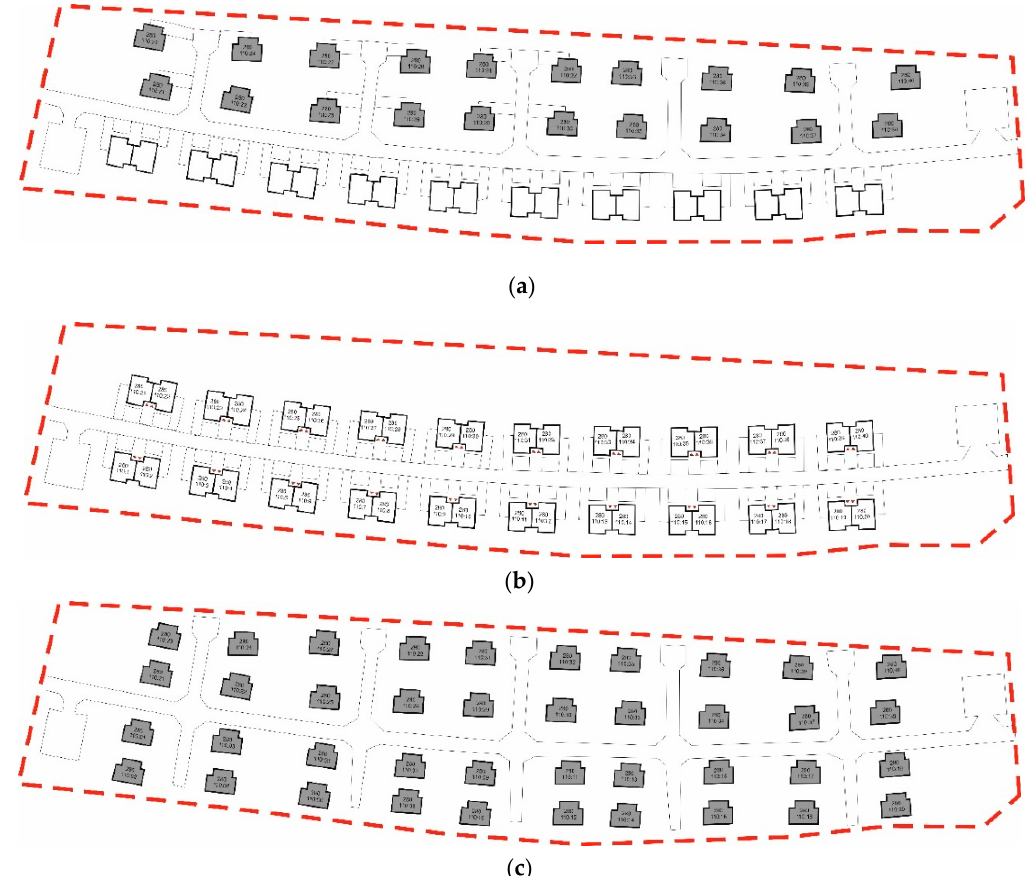
Figure 4. ( a ): Urban layout for alternative A; ( b ): Urban layout for alternative B; ( c ): Urban layout for alternative C.